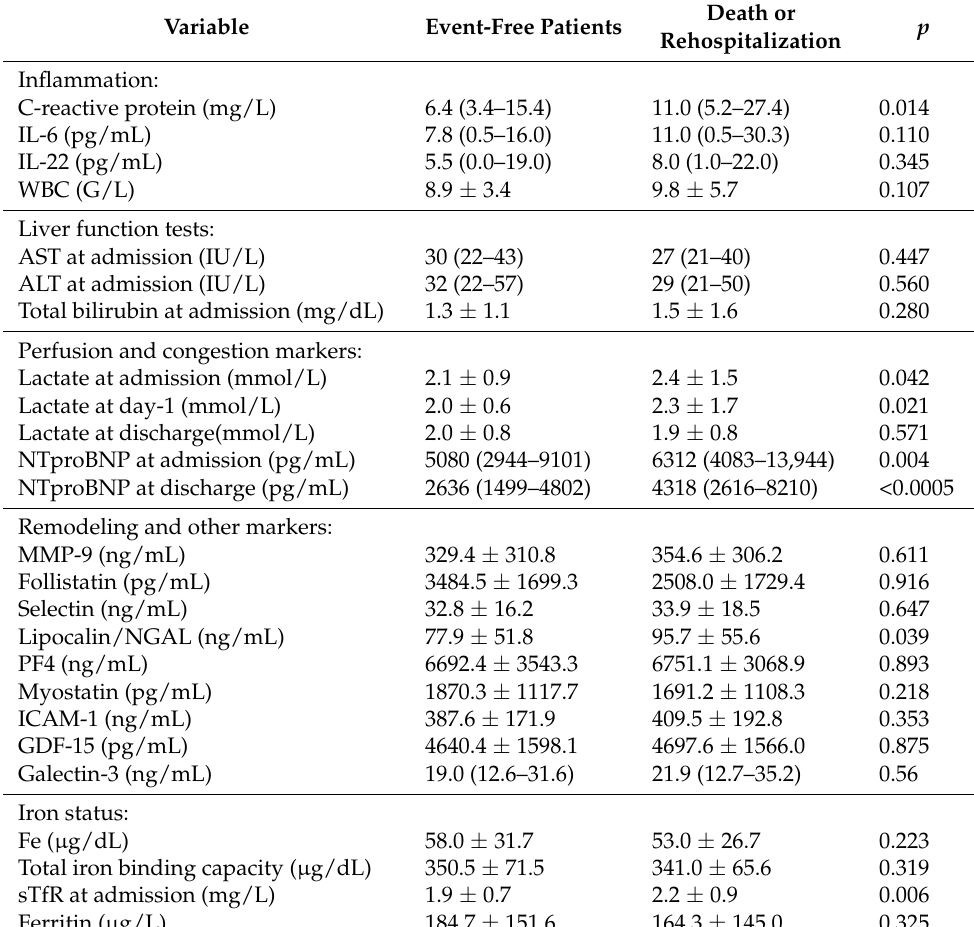
Table 4. Comparison of the selected biomarkers between patients who experienced an event (death or heart failure rehospitalization, whichever occurred first) and the one-year event-free